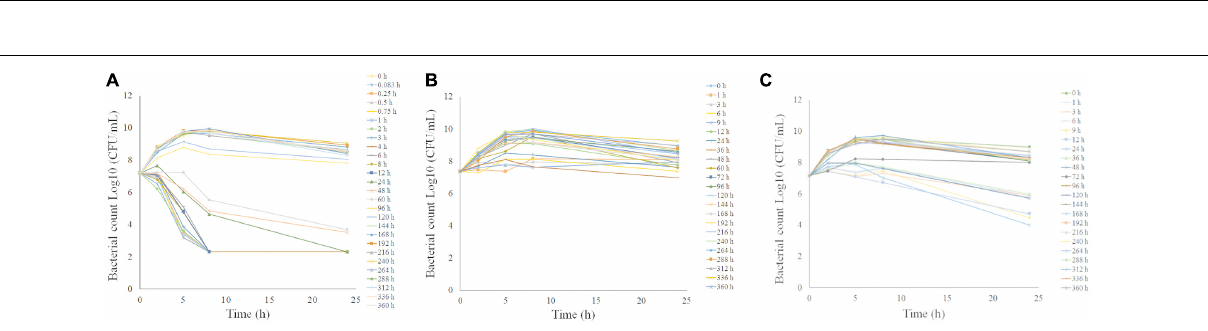
FIGURE 5 | Ex vivo antibacterial activity of tulathromycin against P.multocida in serum (A) , transudate (B) , exudate (C) after i.m. administration at a dosage of 2.5 mg/kg.